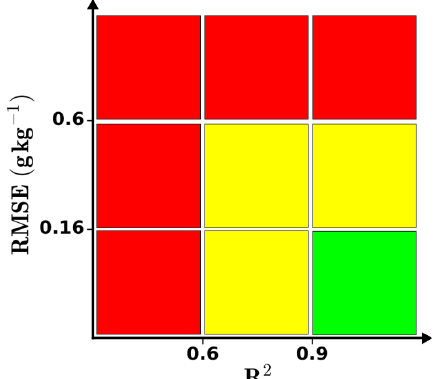
Figure 6. For each sensor (KH20 or LI-COR), the quality of high- rate humidity measurements is assessed against two metrics: R 2 (on the horizontal axis) and RMSE (on the vertical axis). The quality decreases from green to